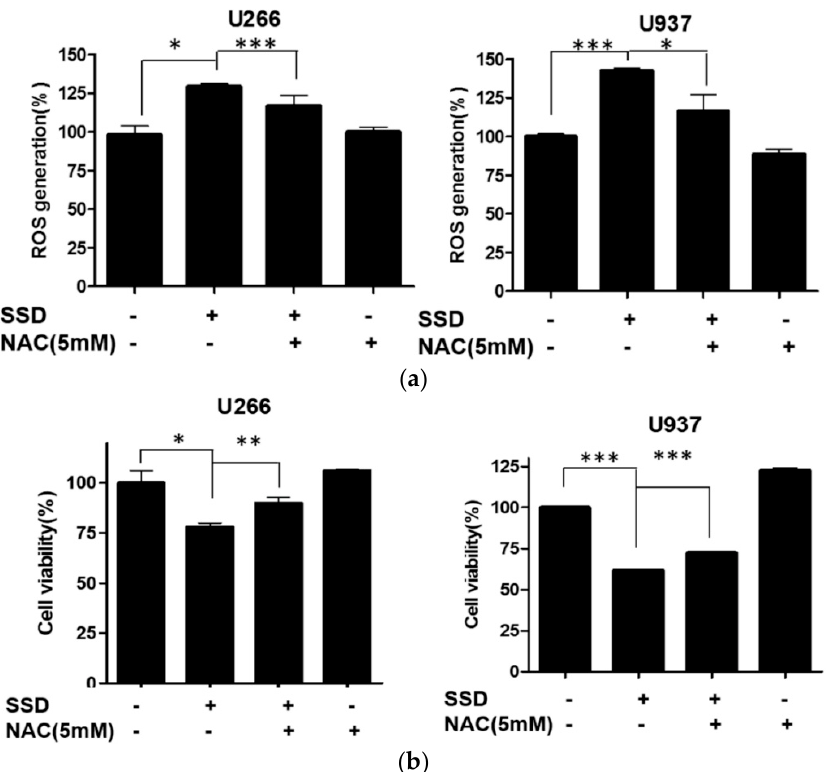
Figure 6. Effect of ROS scavenger on SSD-induced apoptosis in U266 and U937 cells. ( a ) Cells were treated with N -Acetyl- L -cysteine (NAC) for 2 h prior to the exposure to SSD (10 or 20 µg/mL) for 24 h. ROS production was analyzed using oxidation sensitive fluorescent dye (DCFDA) by a cellular reactive oxygen species detection assay kit. ( b ) Cells were seeded into 96-well microplates and pre-exposed to NAC (5 mM) for 2 h, then treated with the indicated concentrations of SSD for 24 h. EZ-CYTOX assay was used to measure cell viability in U266 and U937 cells (sample number n = 3). Results are presented as the means ± SD of three independent experiments. * p < 0.05; ** p < 0.01; *** p < 0.001 between the two groups.